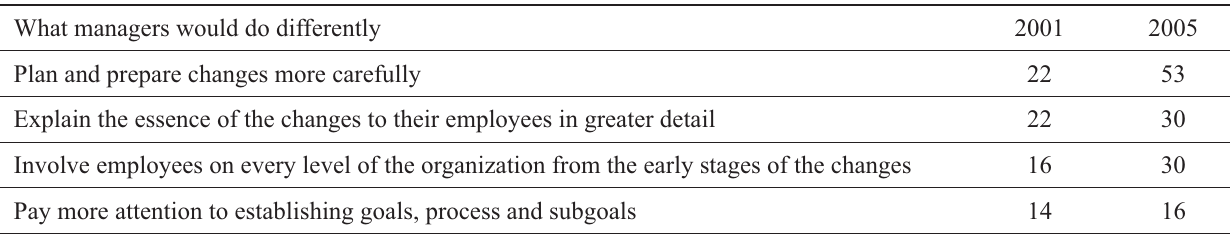
Table 3. Lessons learned (% of